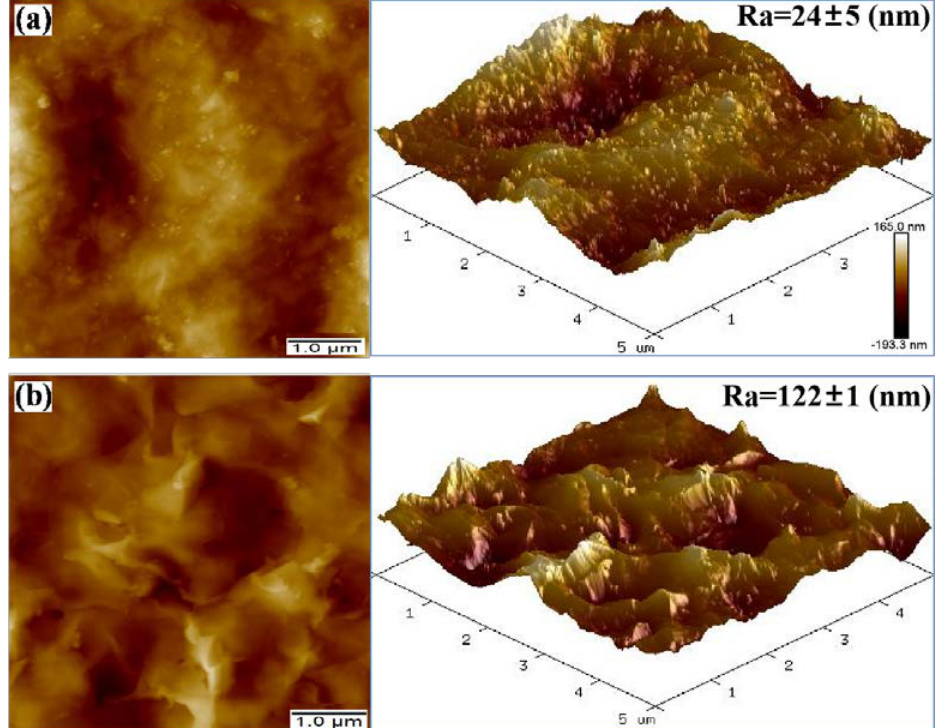
Figure 3. AFM images of ( a ) MXene and ( b ) HSMX membranes.